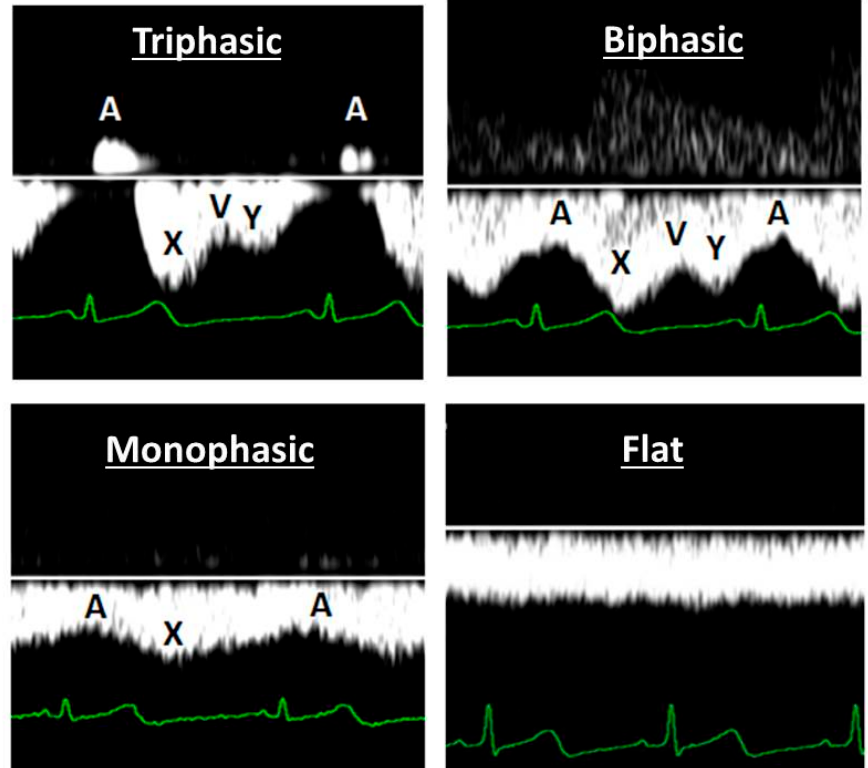
Figure 1. Four common types of venous wave forms observed during Doppler sonography: triphasic, biphasic, monophasic and flat. The A-deflection represents retrograde flow of venous blood from the heart into the vena cava during atrial contraction, in a close time relationship with the electrocardiography P-wave. The X- and Y-deflections represent forward venous flow caused by atrial and ventricular diastole respectively. V represents the opening of the tricuspid valve.